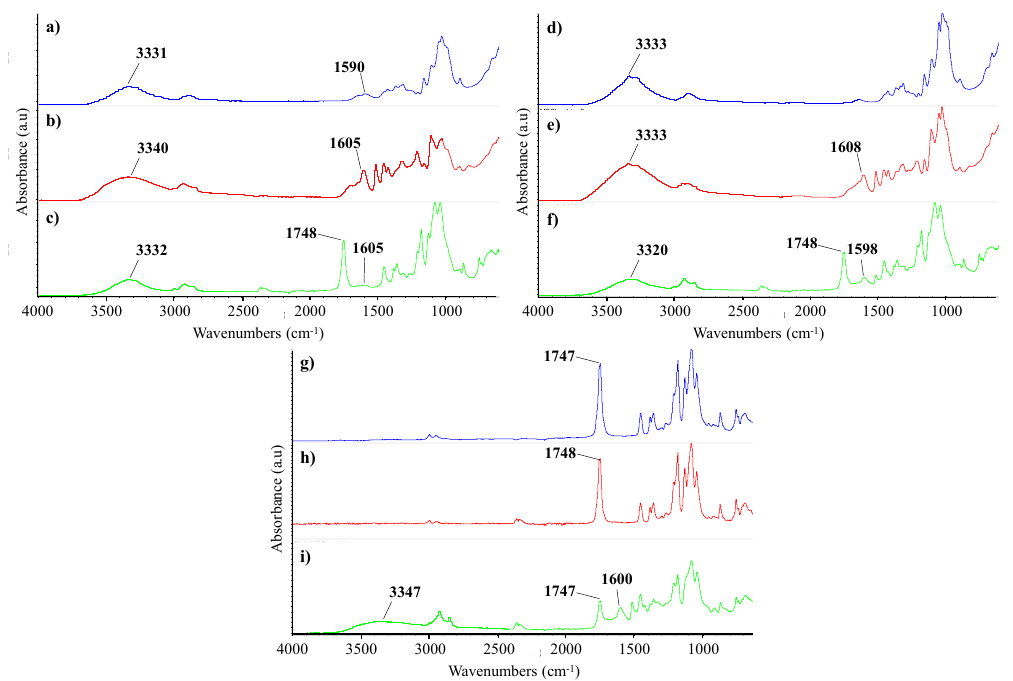
Figure 7. ATR-FTIR spectra of cellulose samples, PLA and biocomposite spheres: ( a ) UP or GUP; ( b ) GUP-L61; ( c ) PLA/UP; ( d ) MCC; ( e ) MCC-L61; ( f ) PLA/GUP-L61; ( g ) PLA; ( h ) PLA/MCC; ( i ) PLA/MCC-L61 (see Table 1 for